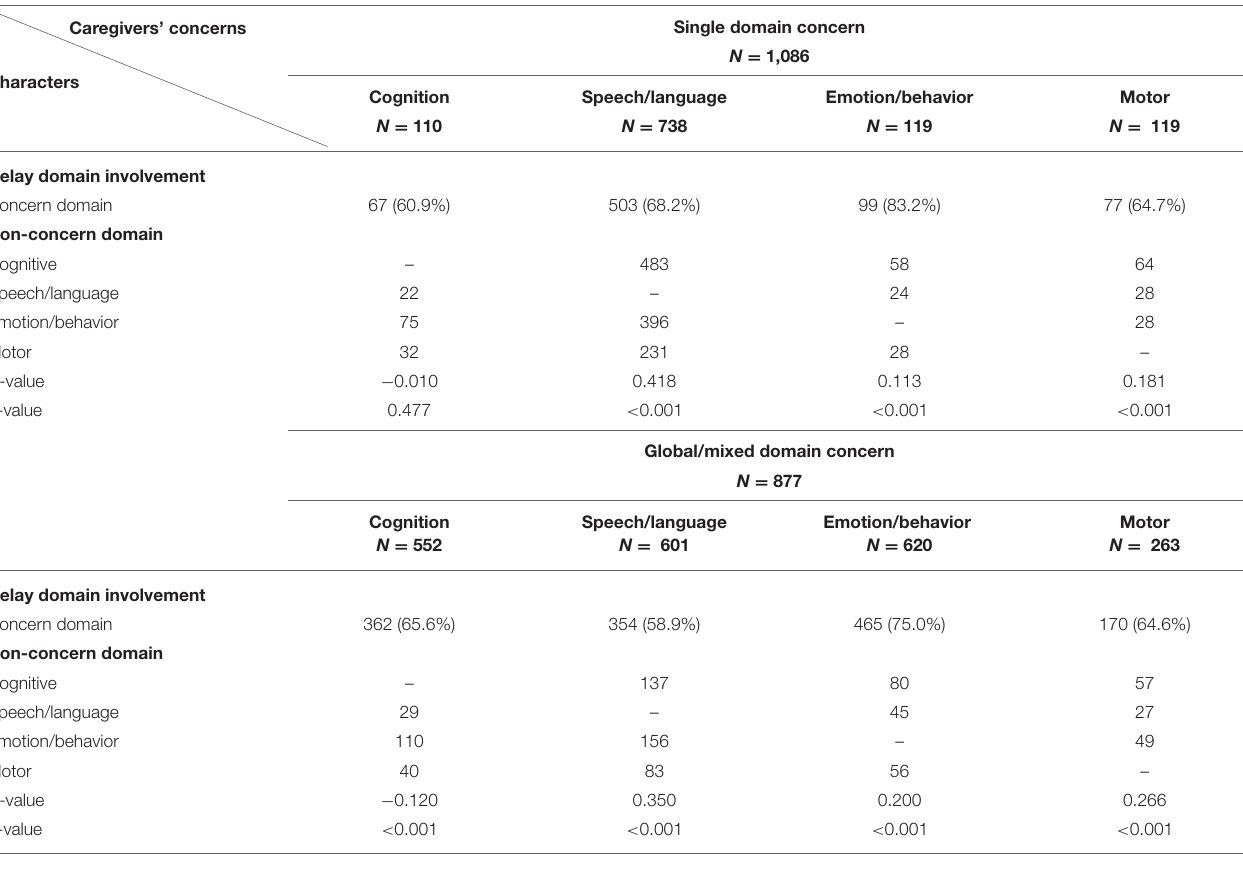
TABLE 3 | Agreement and disagreement of children identified at risk for/with developmental delays corresponding to caregivers’ concerns.